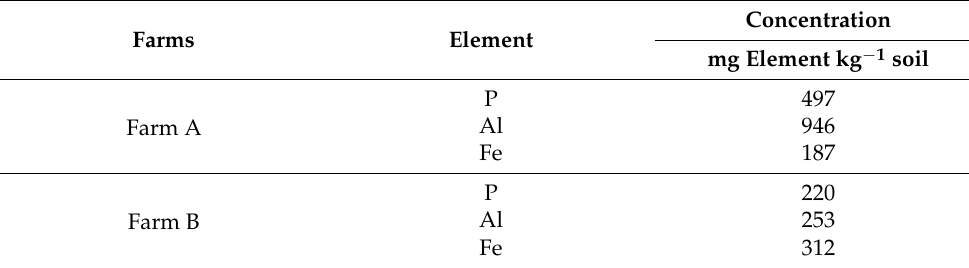
Concentration mg Element kg − 1 soil